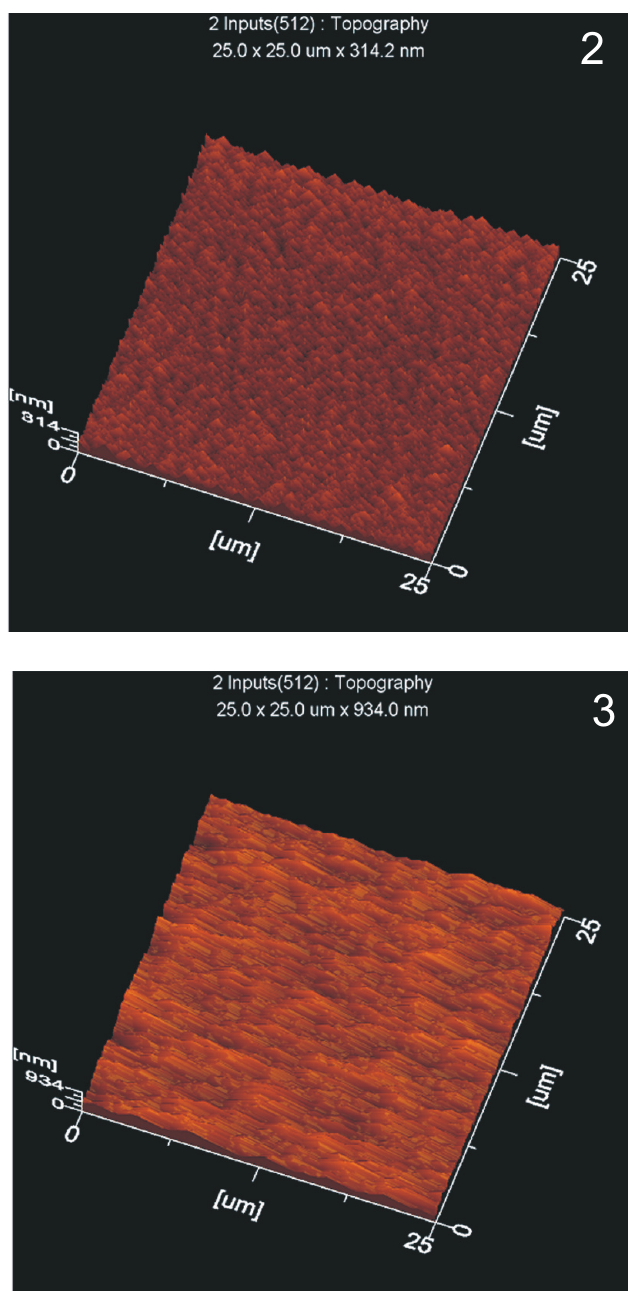
Figure 27. AFM measurements of surfaces smooth and rough in character. Smoothening enhances the wettability, operating pressure: 60 mTorr (8 Pa). ( 1 , 4 ): parylene N, ( 2 , 3 ): parylene C. Top: PECVD with smooth surfaces, bottom: CVD with rough